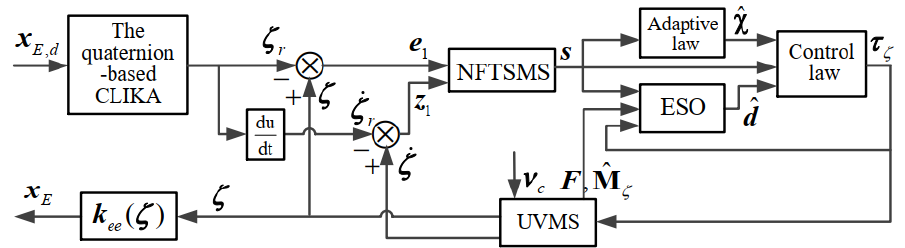
Figure 3. The adaptive NFTSMC diagram based on ESO of the UVMS.